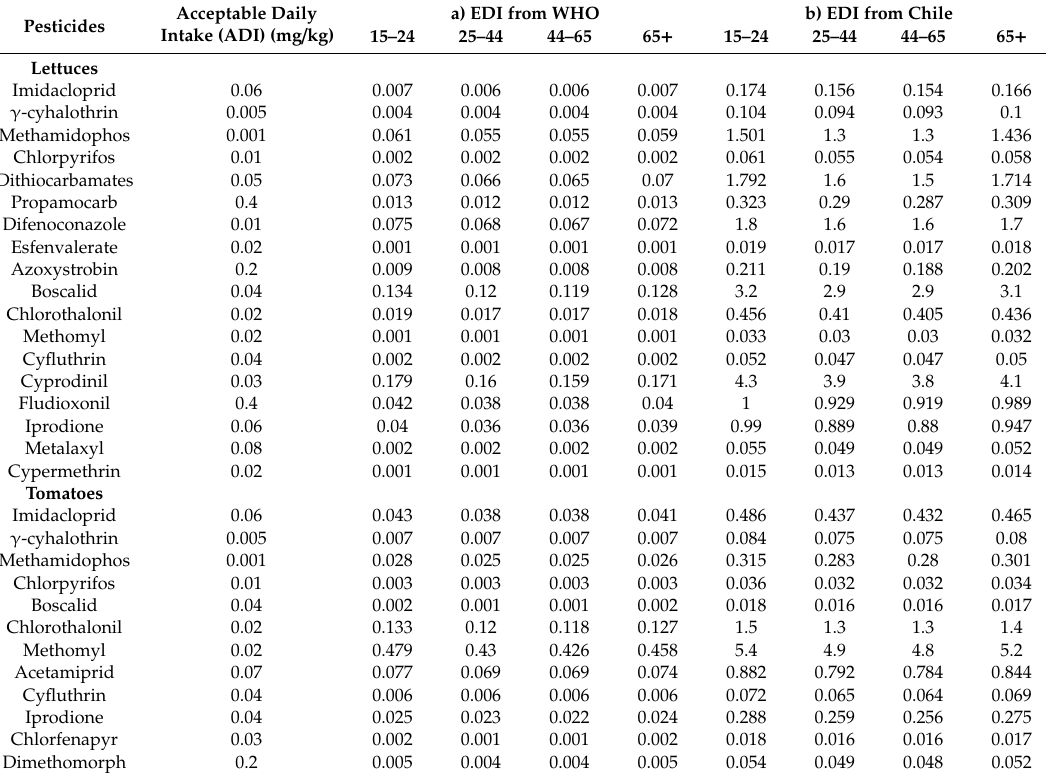
Table 4. The Estimated Daily Intake (mg kg / bw / day) for lettuces and